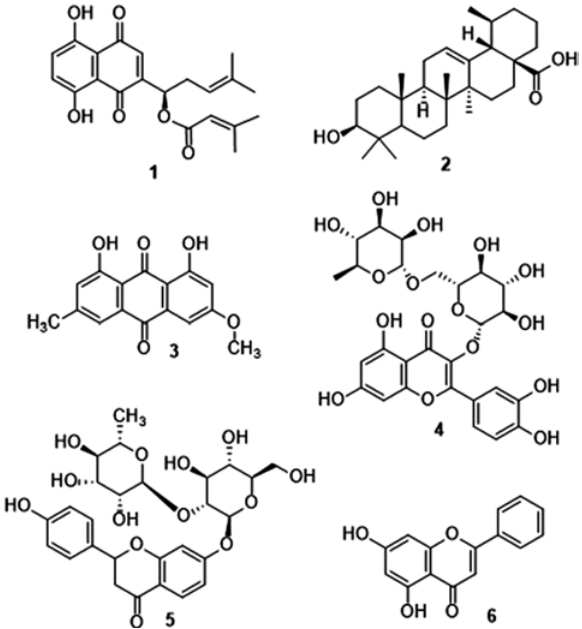
Figure 1: β , β -Dimethylacryl shikonin ( 1 ), ursolic acid ( 2 ), Physcion ( 3 ), Rutin ( 4 ), Naringin ( 5 ), and Chrysin ( 6